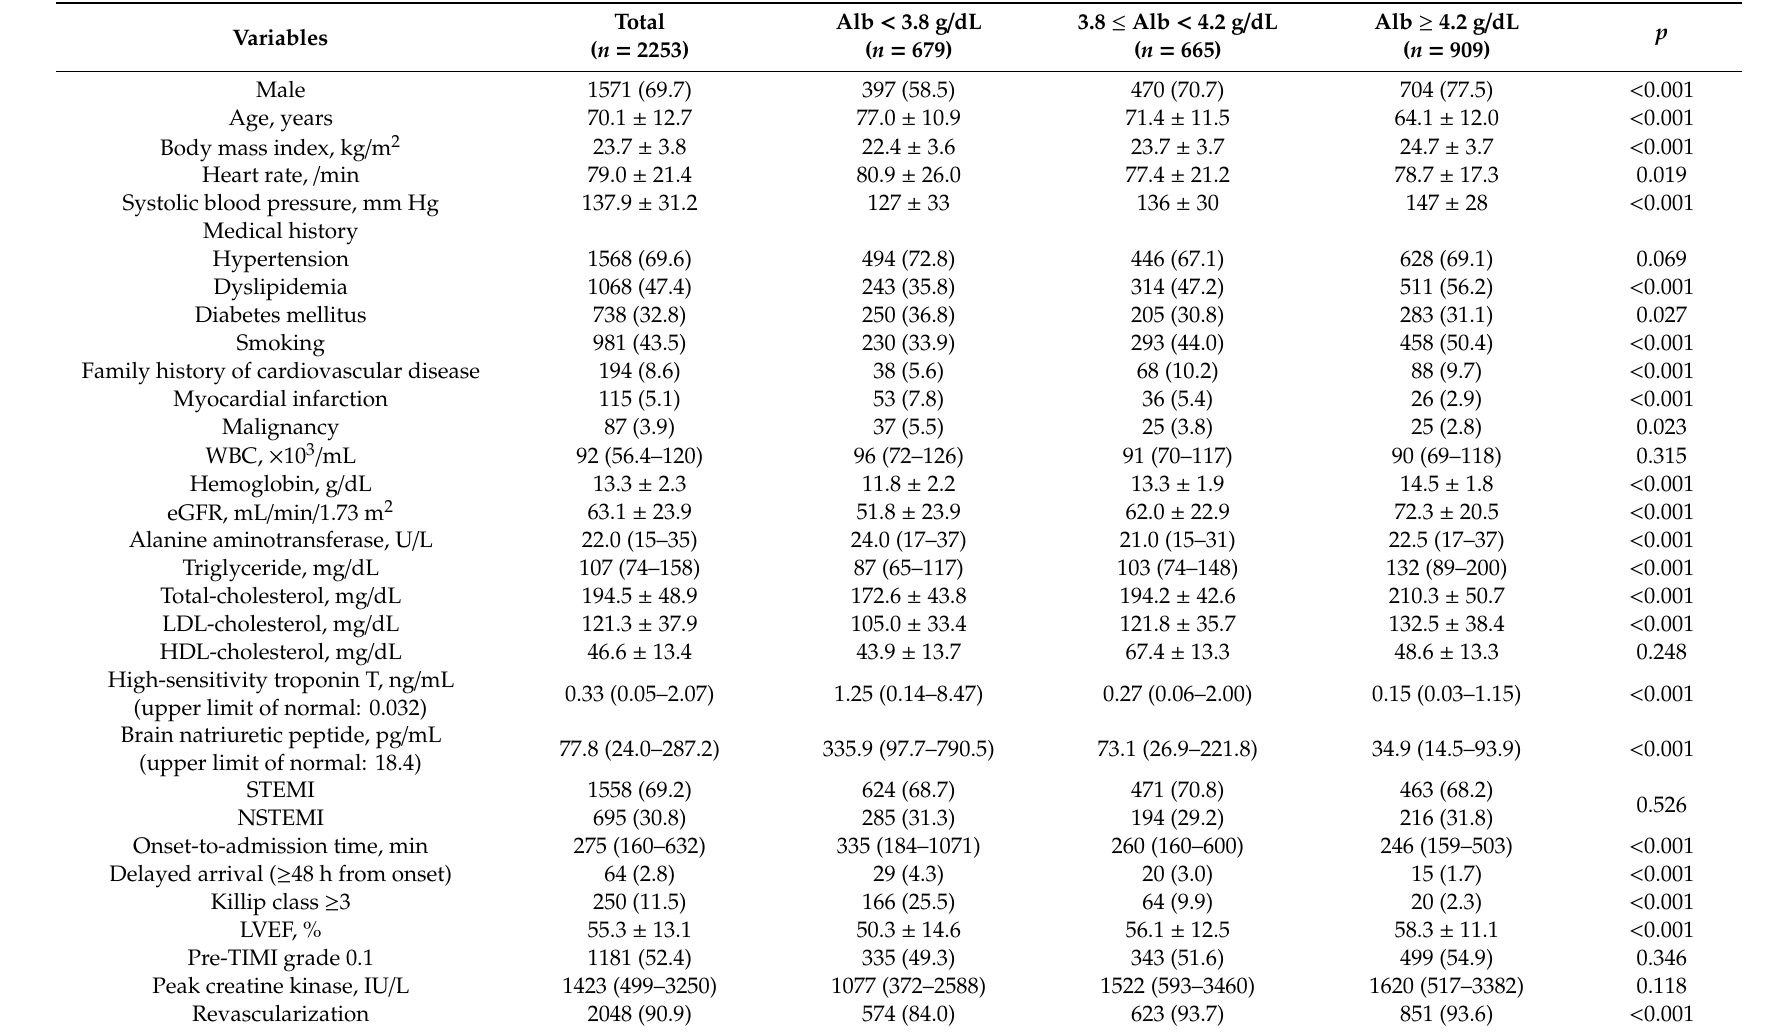
Table 1. Baseline demographics and characteristics of